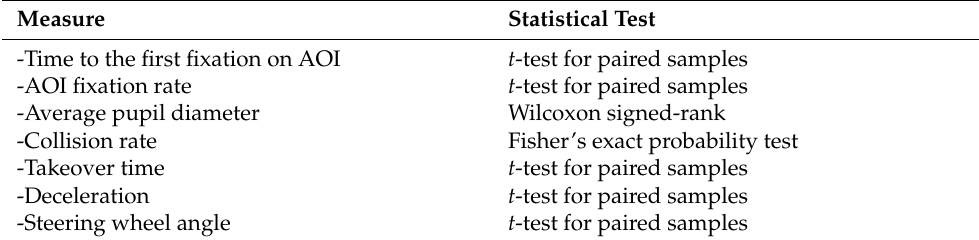
Table 1. Measures and statistical